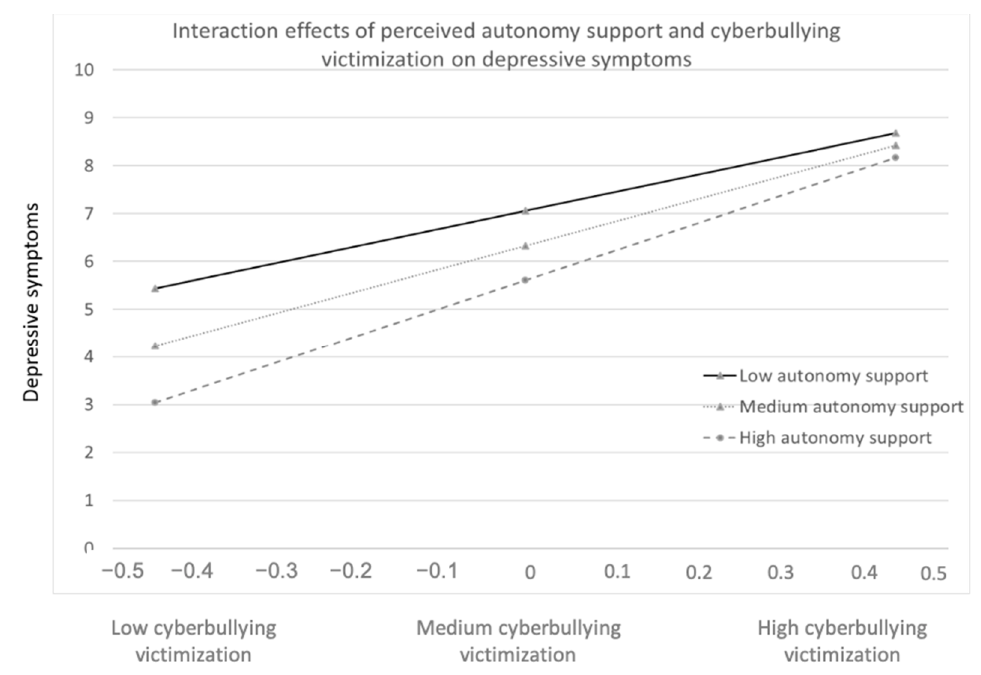
Figure A3. Interactions between autonomy support, cyberbullying victimization, and depres- sive symptoms.